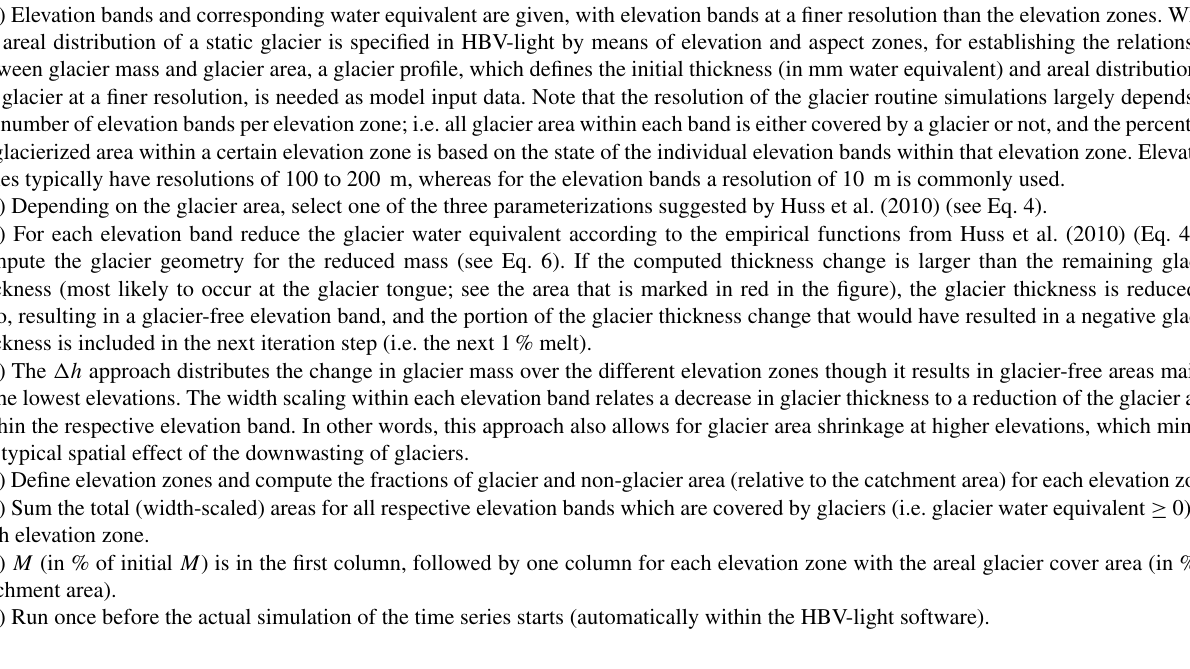
Figure 1. Flowchart describing the update of the glacier geometry depending on glacier mass balance changes in HBV-light. Additional information is given in the following notes (numbers refer to corresponding numbers in the